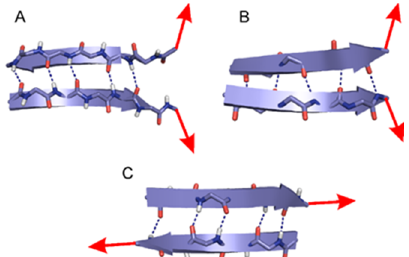
Figure 1. Schematic description of lateral and sheared unfolding directions of β-sheet motifs studied here. Secondary structures shown as ribbons and backbone atoms as sticks. Interstrand H-bonds indicated by dark blue dashed lines. ( A ) Lateral unfolding of antiparallel β-sheet (AP) motif. ( B ) Lateral unfolding of parallel (P) β-sheet motif. ( C ) Sheared unfolding of an AP motif .